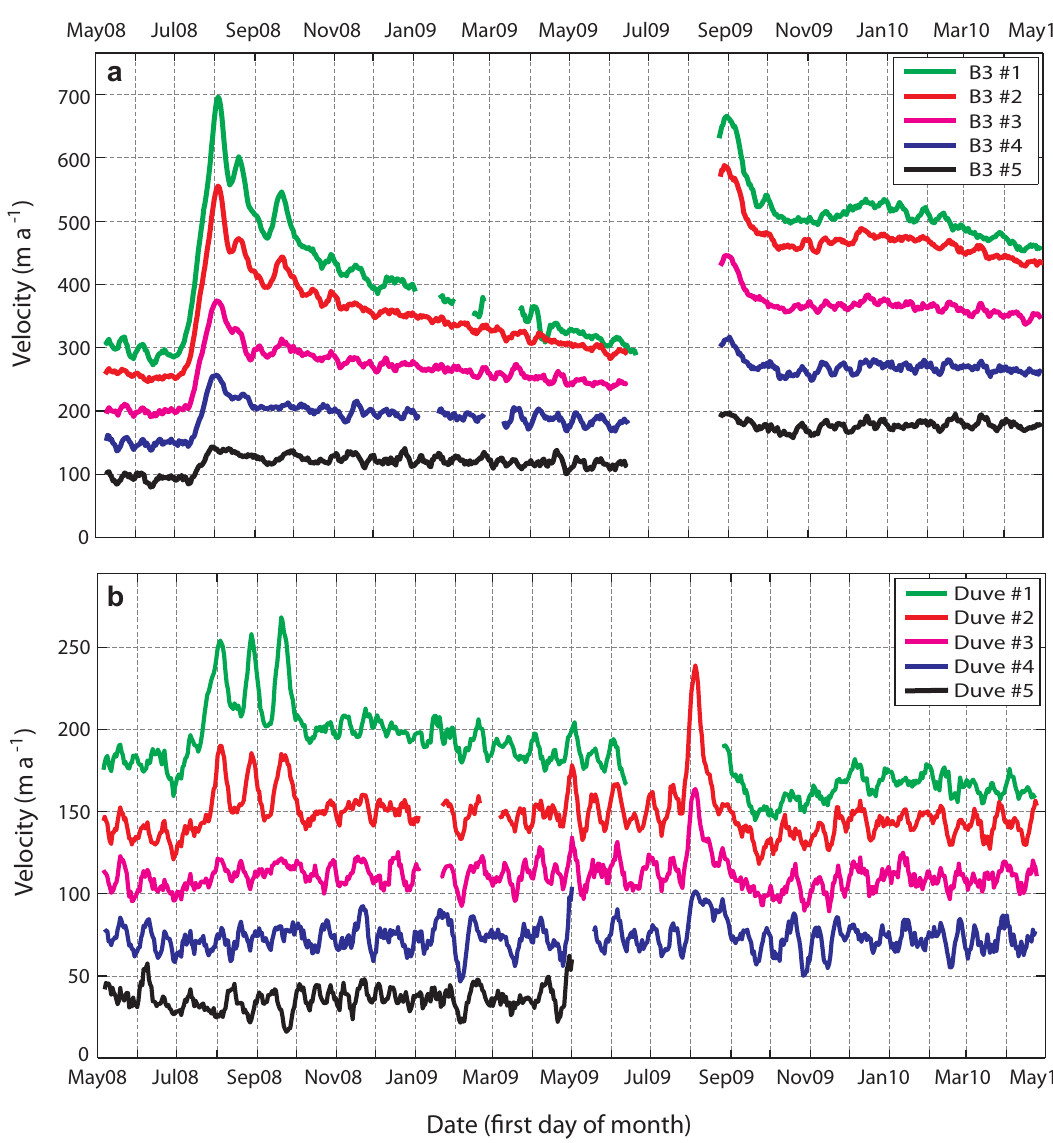
Fig. 4. Flow velocities along the central flowline of Basin-3 (a) and Duvebreen (b) , during May